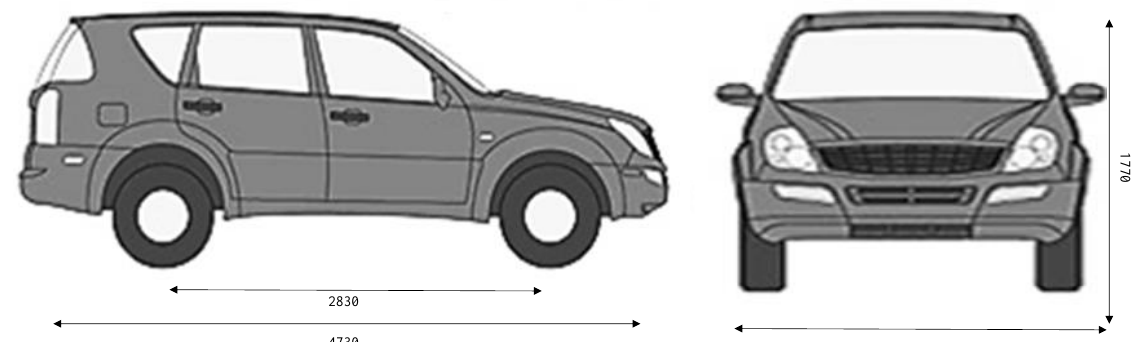
Figure 2. Schematic of a 2004 Ssangyong Rexton SUV (dimensions are in